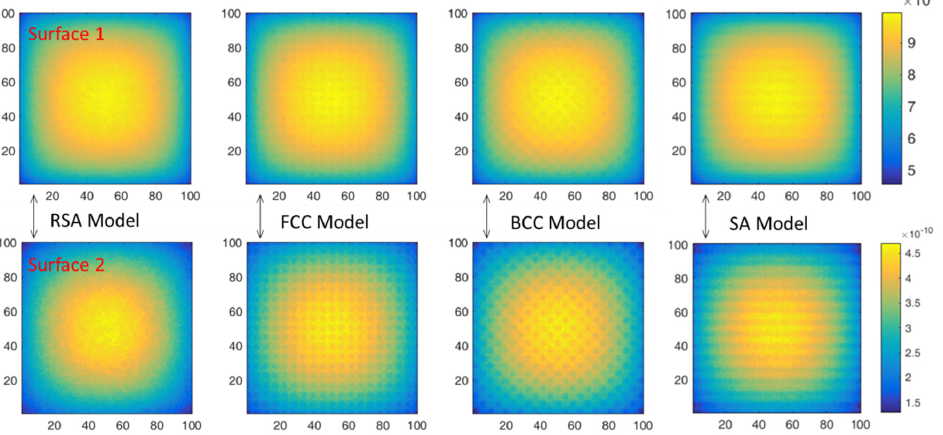
Figure 8. In the case of 0.0253 eV neutrons, the neutron flux distributions at surface 1 and surface 2 under different spatial arrangements.